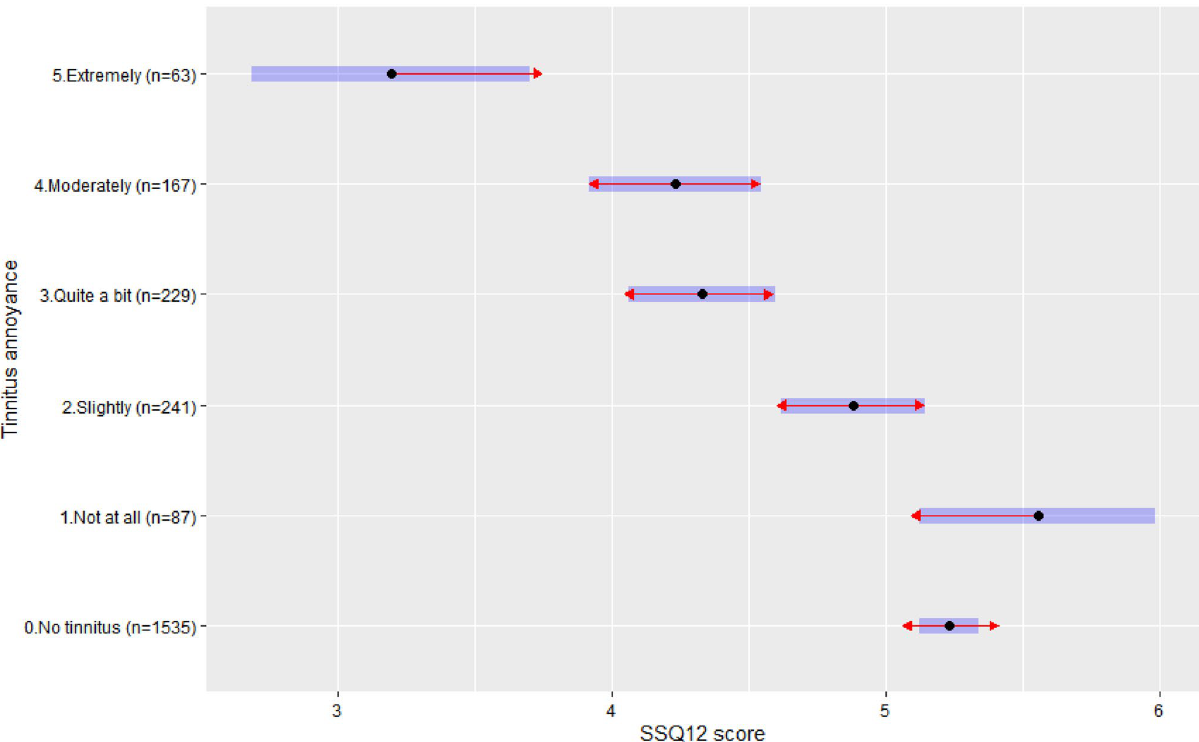
Figure 2. SSQ12 scores by tinnitus annoyance levels. Blue bars are the 95% confidence intervals for the estimated marginal means, the red arrows are for the comparisons among them. If an arrow from one group overlaps with an arrow from another group, the difference is not statistically significant (Tukey tests, p >